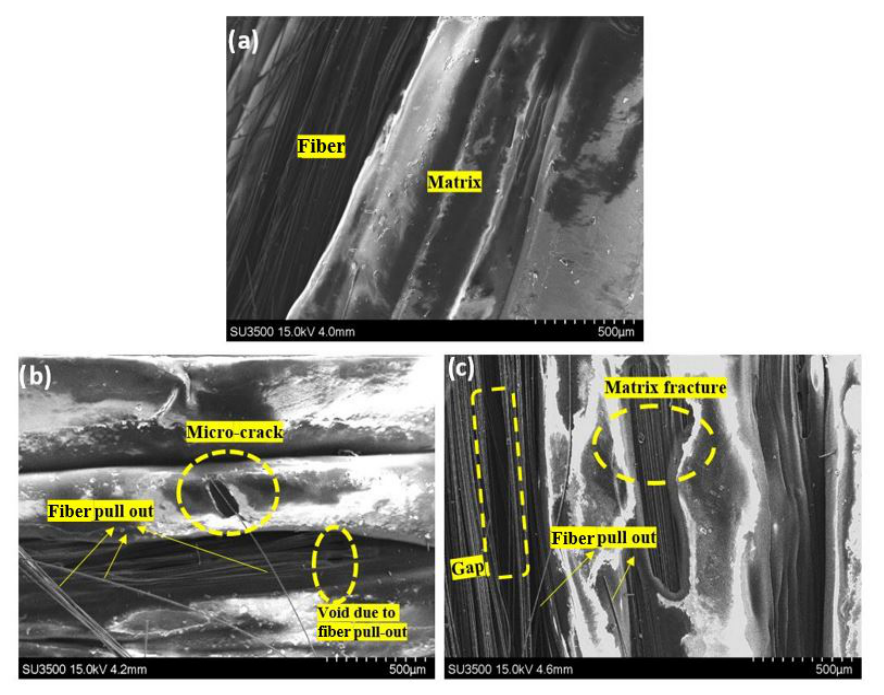
Figure 10. Scanning electron microscope images of the specimen after destructive tensile testing: ( a ) intact (untreated); ( b ) stable continuous at 65 ◦ C; ( c ) cyclic between 50 and 70 ◦ C in a 60 ◦ , 0 ◦ , and 90 ◦ view angle,